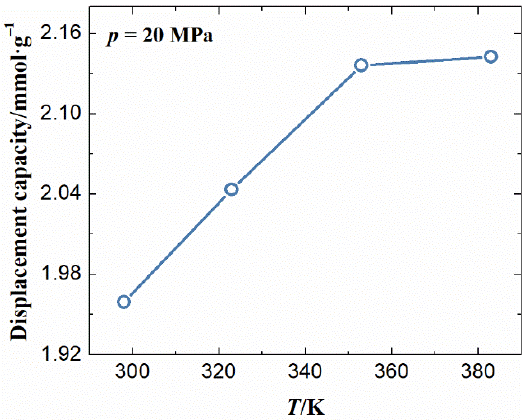
Figure 9. The terminal displacement capacity of CH 4 by CO 2 as a function of temperature.